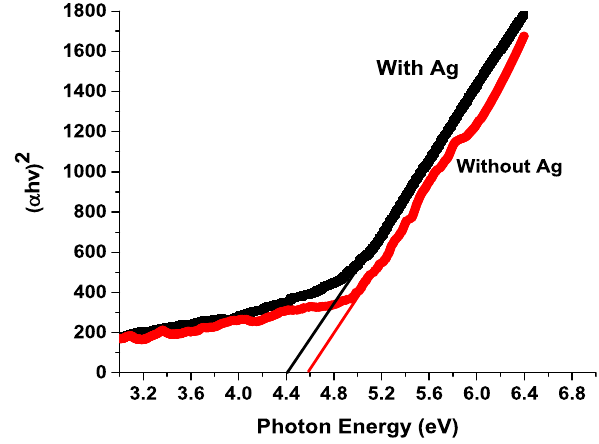
Figure 4. Plot of (αhv) 2 versus photon energy.